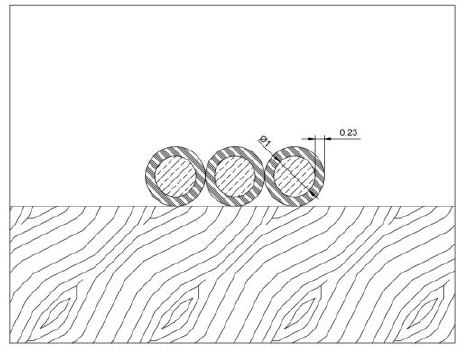
Figure 9. The model representation of the two-wire harness connection between LISN and DUT.